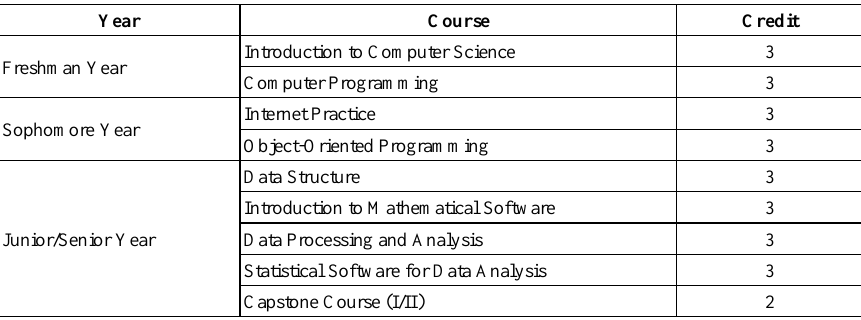
Table 1. Overview of computer science courses in the department of applied